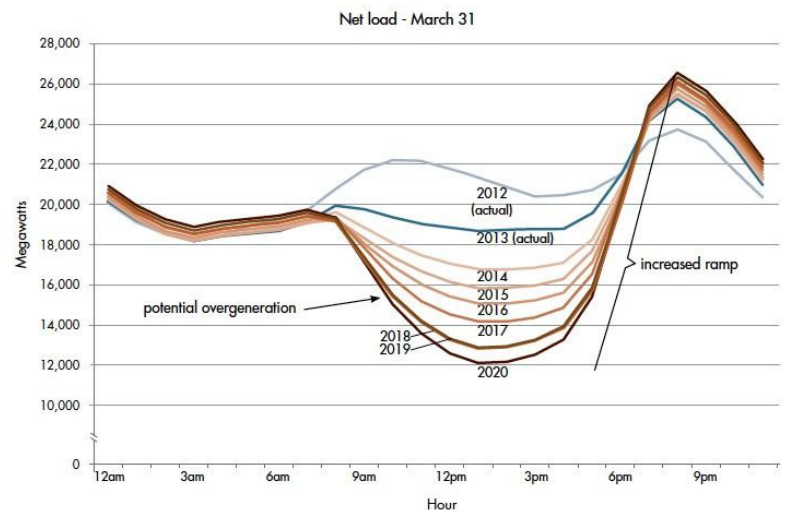
Figure 1. A common duck curve in California, USA